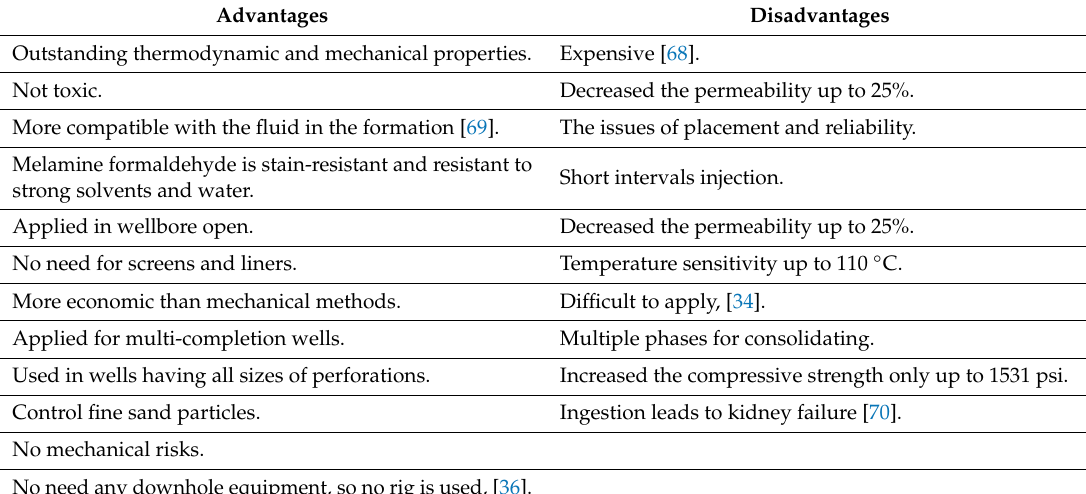
Table 8. Advantages and disadvantages of amino-aldehyde polymer.